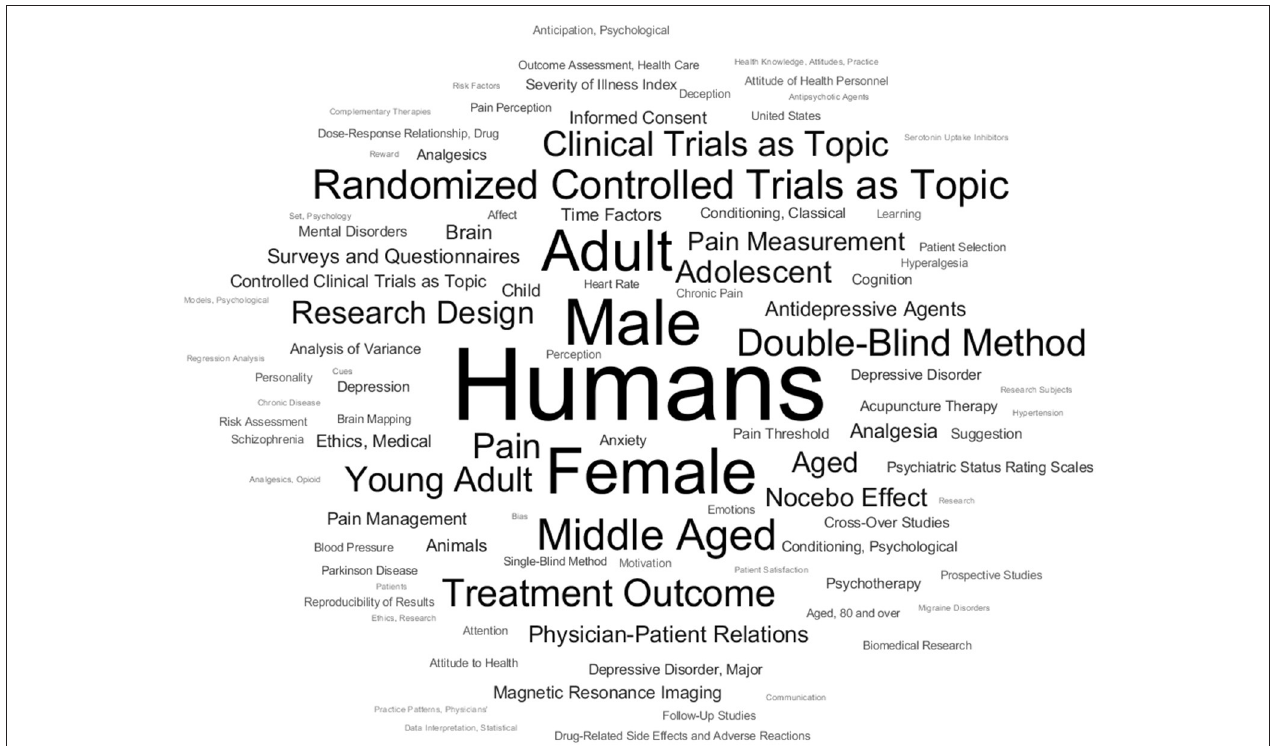
FIGURE 2 | Word cloud of (major) Medical Subject Headings (MeSH) used in the JIPS database. Larger words indicate more frequent occurrence.